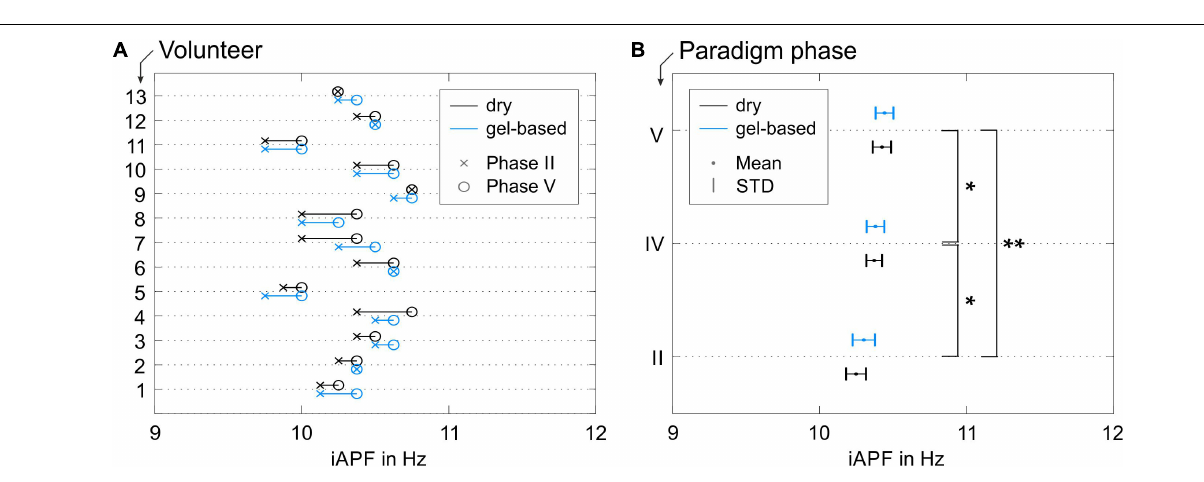
FIGURE 6 | iAPF results for both electrode types: (A) individual results in Phase II (pre-cycling condition) and Phase V (passive recovery condition) for all volunteers with alpha activity exceeding the threshold criterion; (B) grand average mean and STD calculated over all volunteers in Phases II (pre-cycling condition), IV (active recovery), and V (passive recovery). Asterisks in panel (B) indicate significant differences between the iAPF values in the different paradigm phases ( ∗ p < 0.05; ∗∗ p <